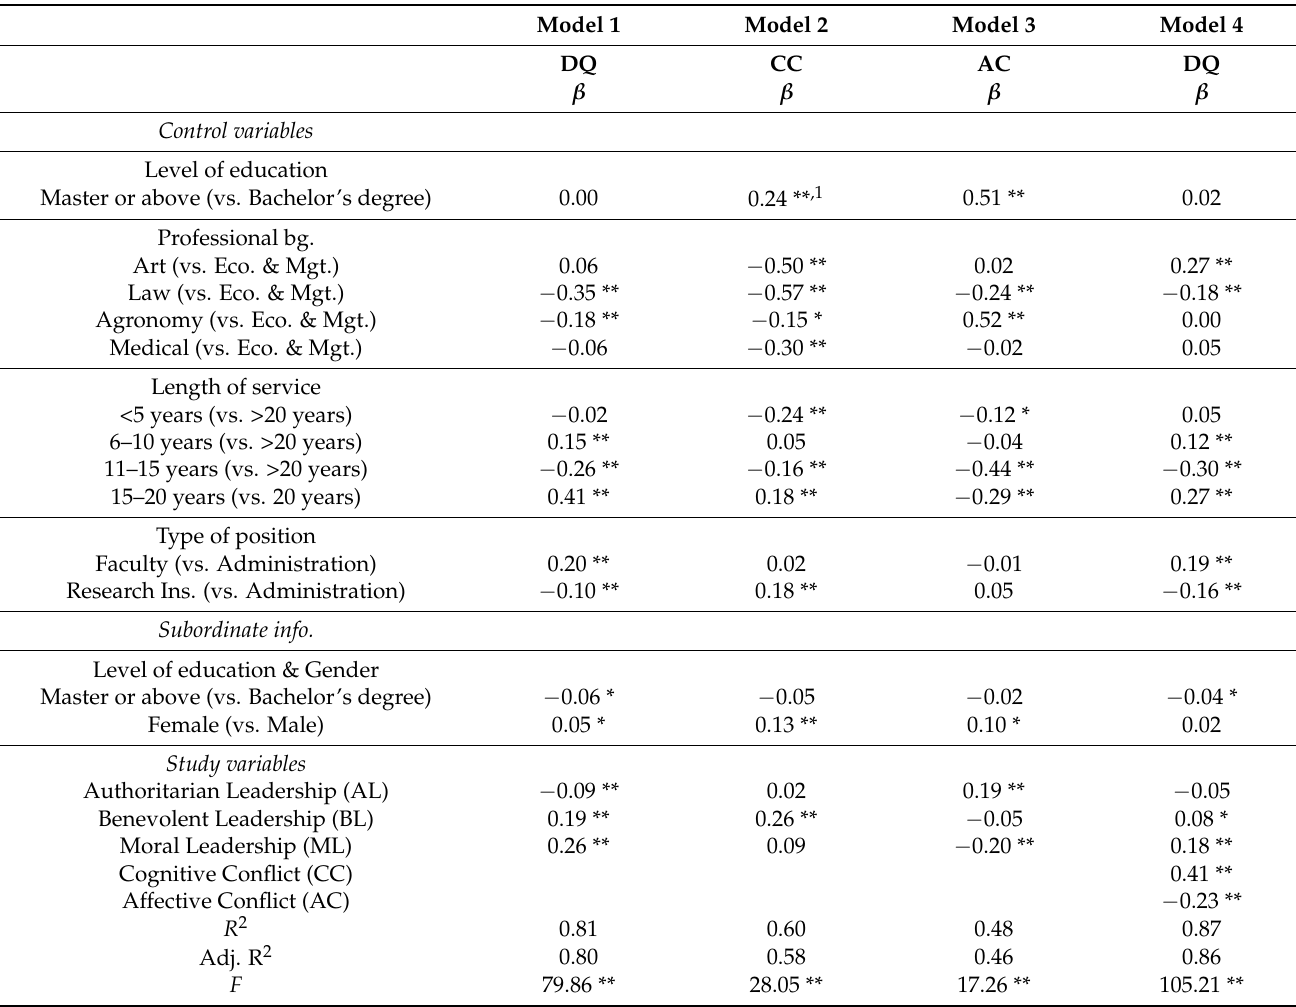
Table 3. Hierarchical Regression Analysis: Control Variables, Paternalistic Leadership, Intra-team